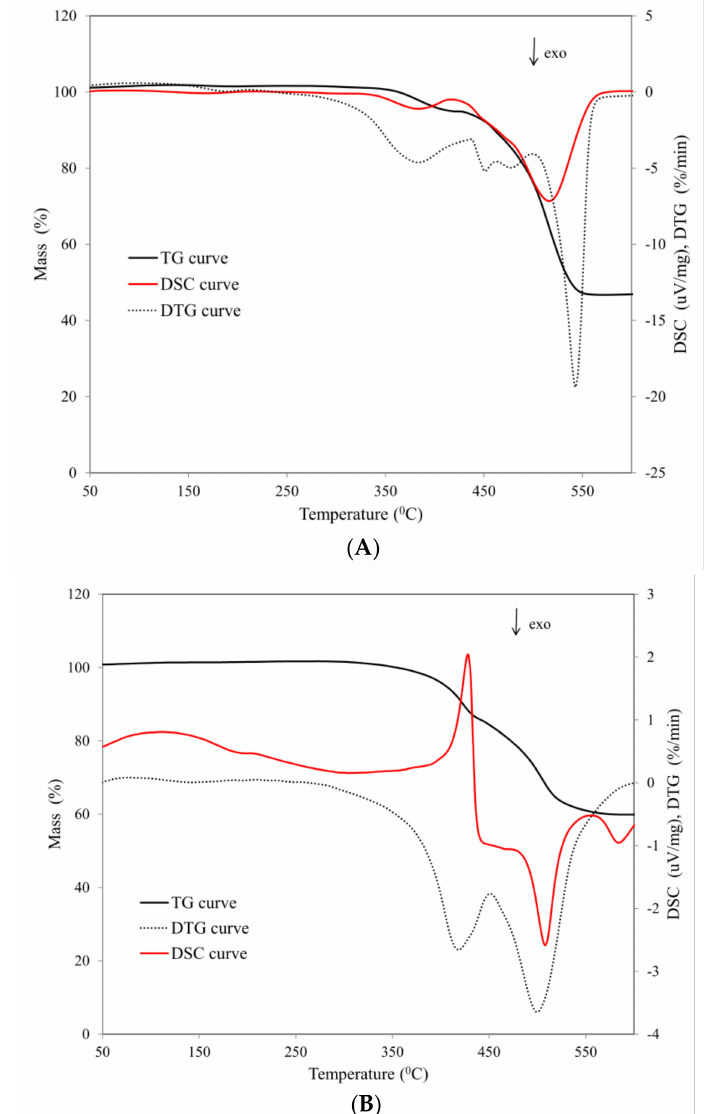
Figure 3. Thermal curves: ( A ) SR-0 composite ( B ) SR-5